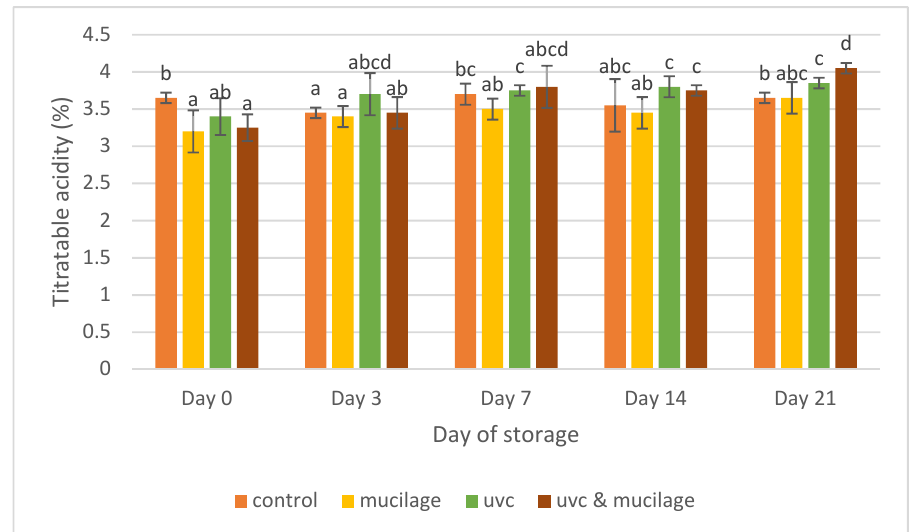
Figure 5. Effect of mucilage coating and UV-C on titratable acidity. Values followed by different letters within the same column are significantly different ( p < 0.05) ( n = 12).